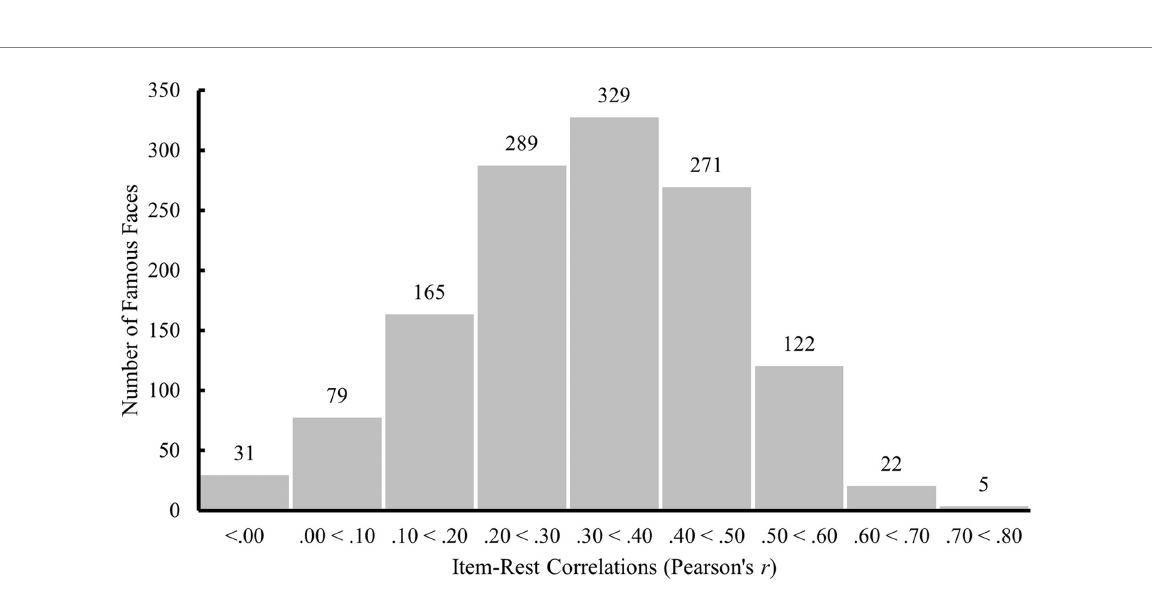
FIGURE 5 Distribution of item-rest correlations between participants’ scores on a famous face and total scores for all other famous faces in step 3. Labels on top of each bar indicate the number of famous faces per interval [Item-rest correlations could not be computed for 407 famous faces which were either correctly (one face) or incorrectly (406 faces) named by all